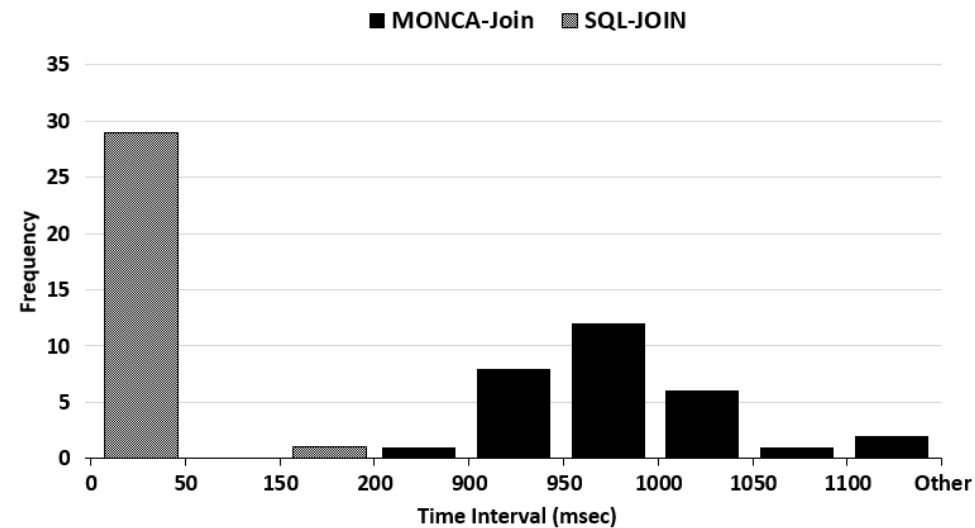
Figure 16. Frequency histogram showing response times of MySQL and MongoDB (application-layer) join